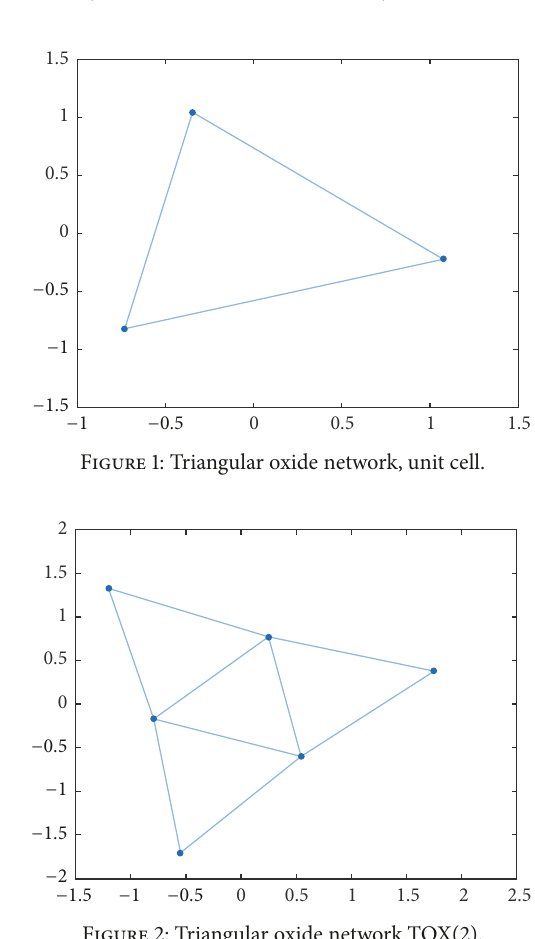
Figure 2: Triangular oxide network TOX(2).